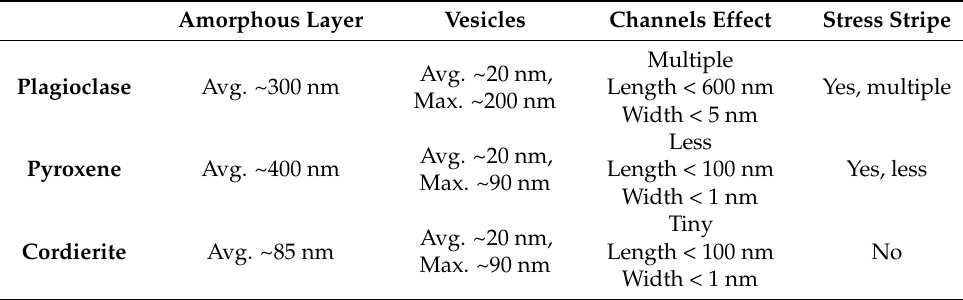
Table 1. Modification characteristics of the three FIB cross-sections.